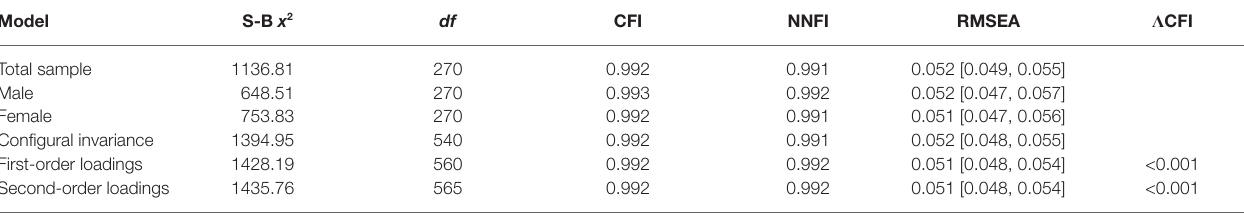
TABLE 3 | Fit indices for the second-order factor model of the Spanish version of the LSS.